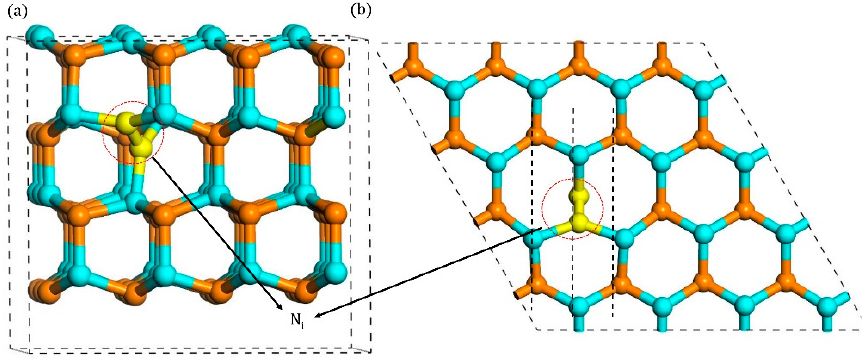
Figure A2. Configurations of B 2 type split interstitial: ( a ) side view and ( b ) top view.